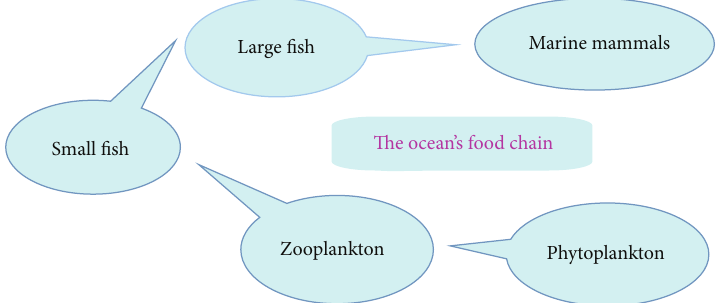
Figure 1: The ocean’s food